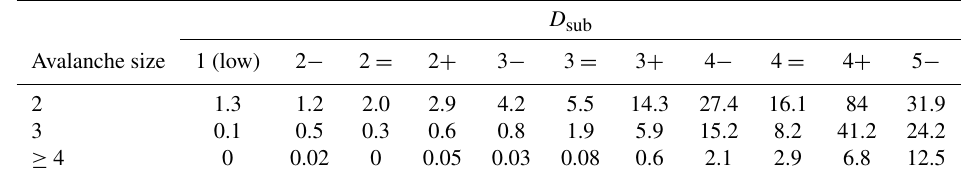
Table 3. Spatial density of natural avalanches ˜ ρ nat , i (or number of avalanches) of size i per 1000km 2 for each of the sub-levels D sub . Median values are